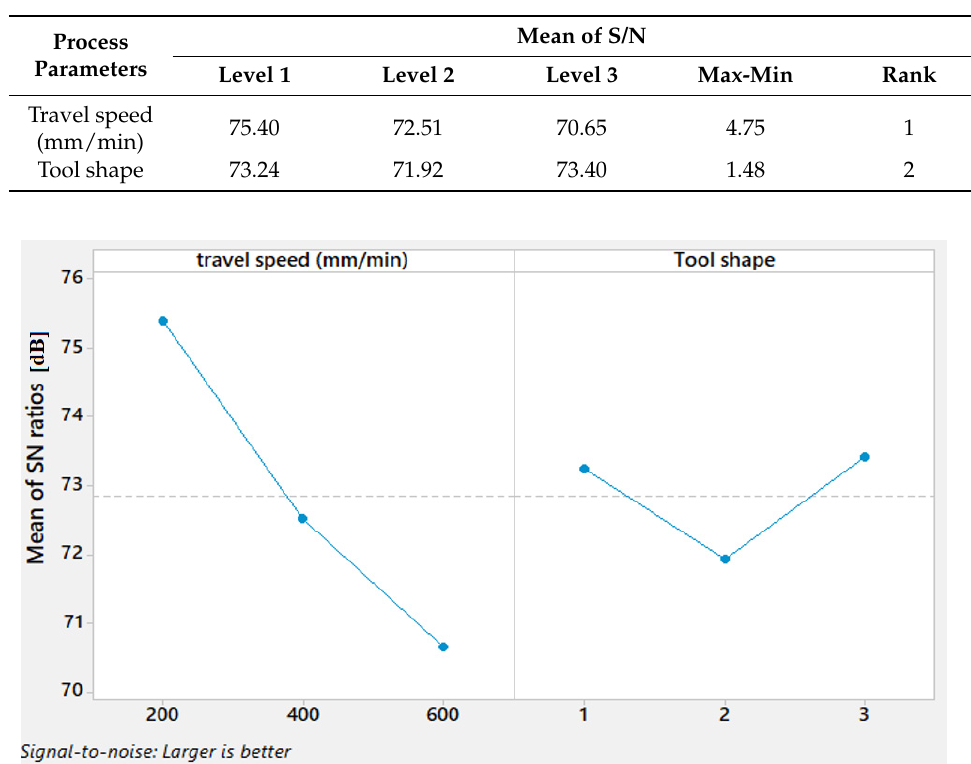
Figure 9. Mean S/N ratio for TSL of AA1050 thick lap joints.